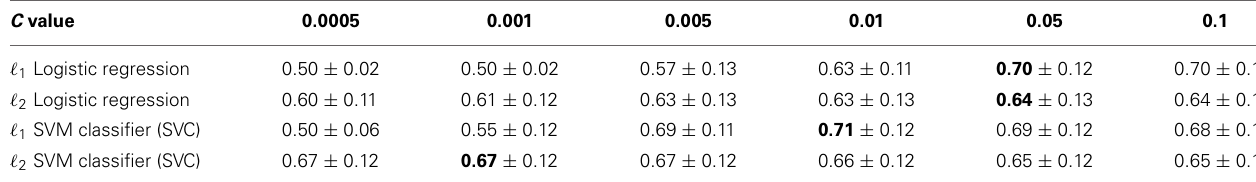
Table 1 | Five fold cross validation accuracy scores obtained for different values of parameter C ( ± SD ), best scores are shown in